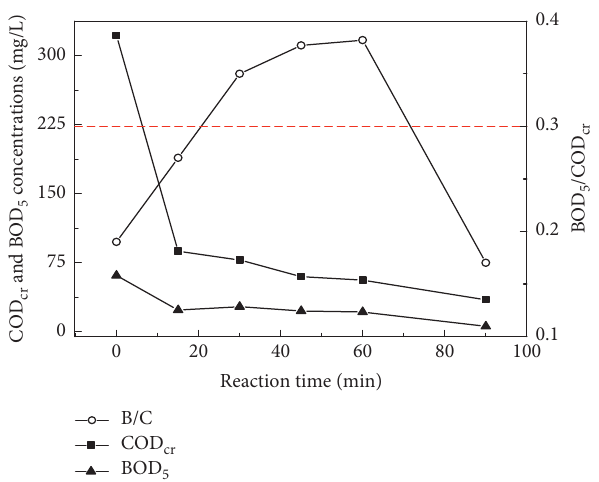
Figure 12: Effect of Fenton reaction time on biodegradability of